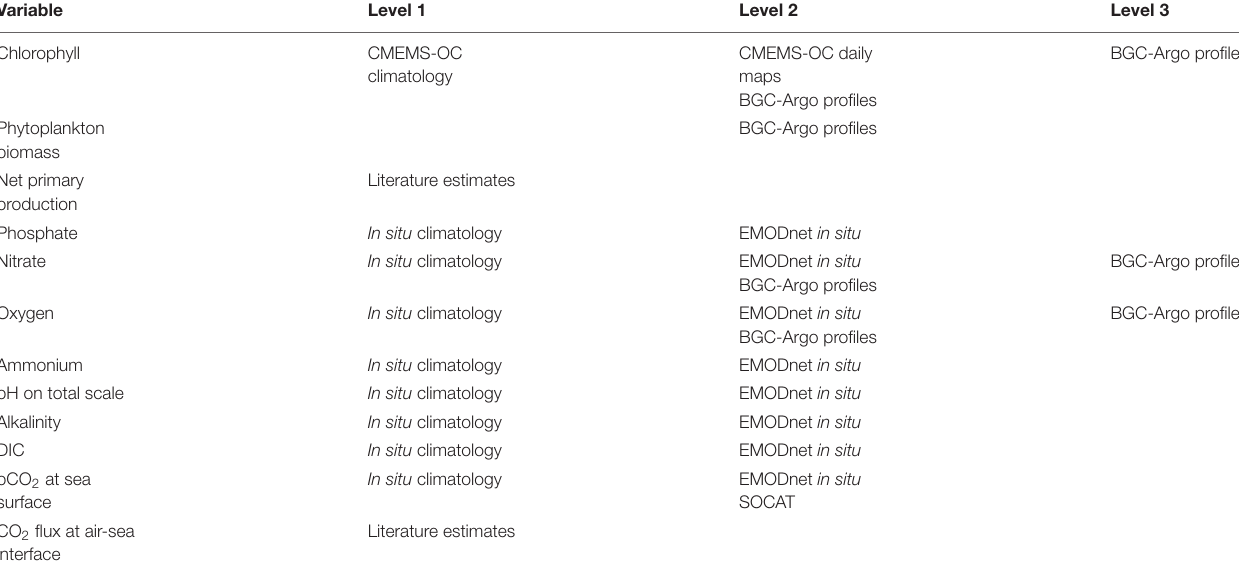
TABLE 2 | Reference datasets used for the 3-level validation.